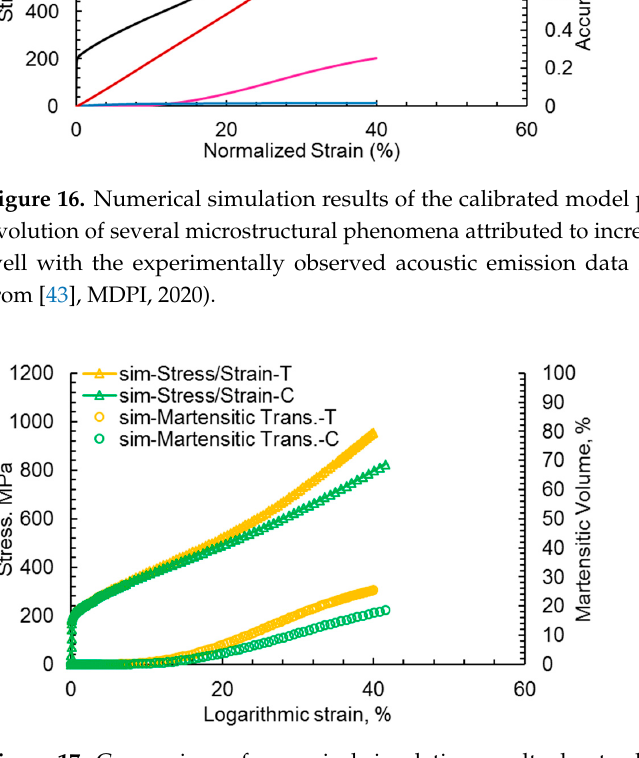
Figure 17. Comparison of numerical simulation results due to change in the load direction. The simulations were run for tension (T) and compression (C) cases (reprinted with permission from simulations were run for tension (T) and compression (C) cases (reprinted from [43], MDPI,